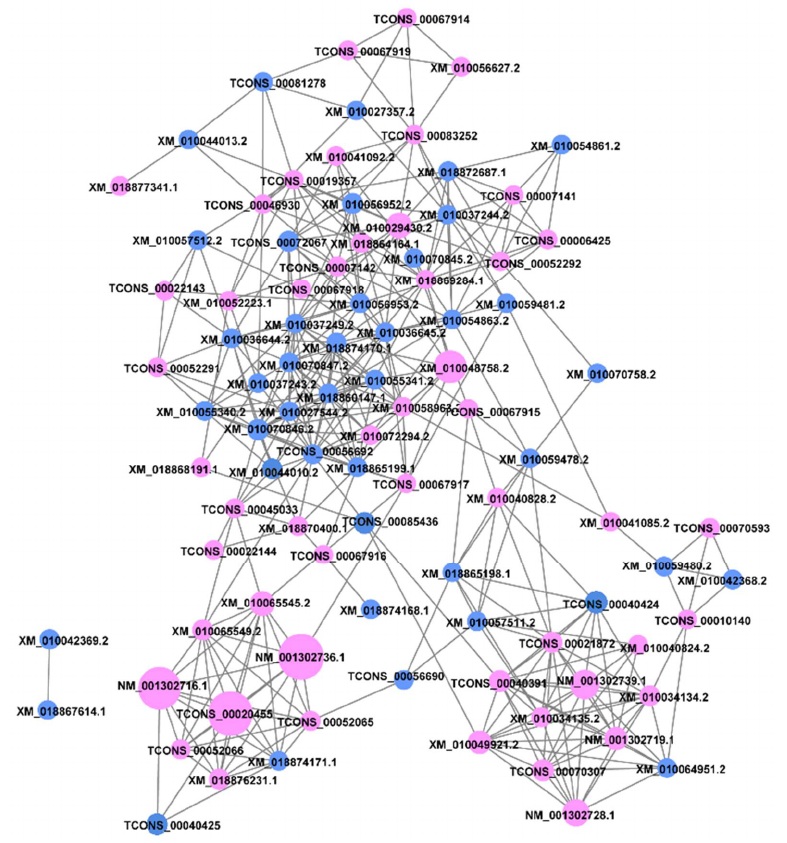
Figure 7. Co-expression network of the 100 transcripts of CesA and Csl genes, based on RNA-seq dataset. The CesA genes are marked in purple, and the Csl genes are marked in blue. The larger the sum of the FPKM values of the gene in all samples, the larger the circular area.